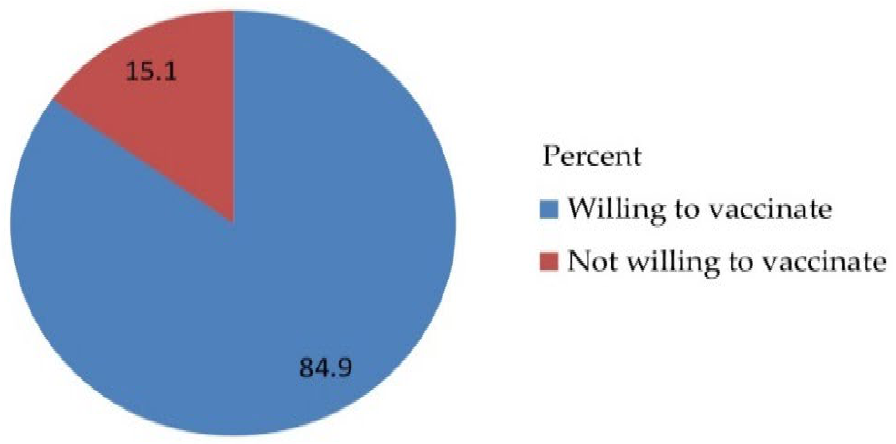
Figure 3. Acceptance-related questionnaire of the respondents on awareness, acceptance, and associated factors of human papillomavirus vaccine among parents of daughters in Hadiya zone, southern Ethiopia, 2021 (n = 530).